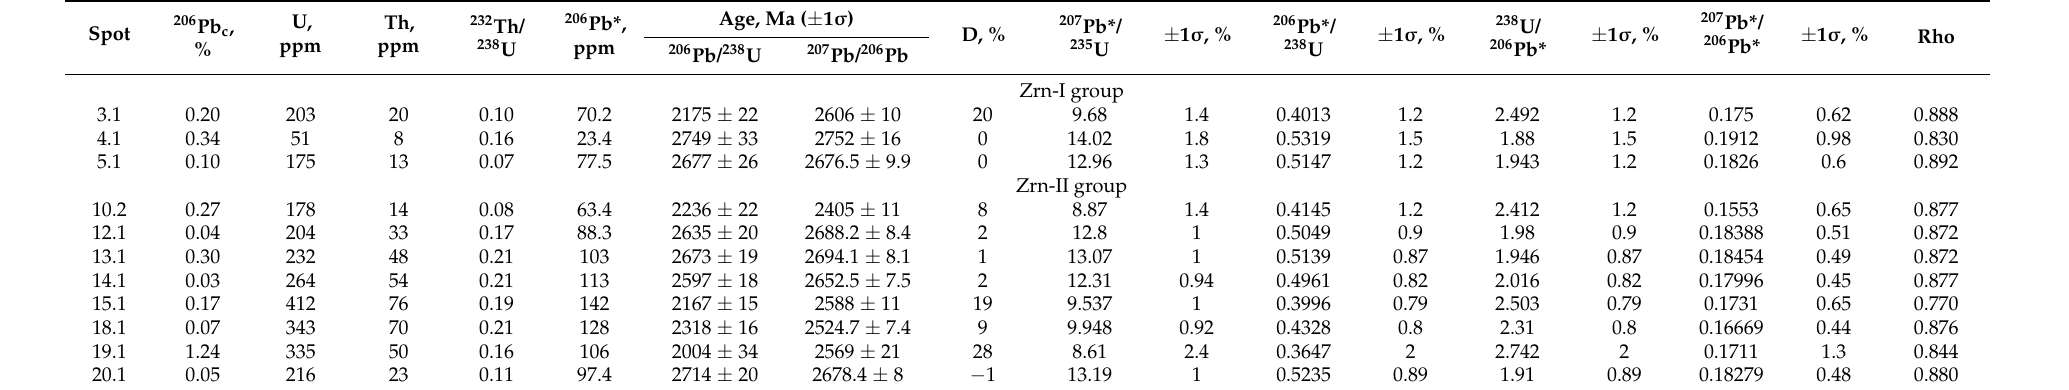
Table 1. U-Th-Pb isotope (SHRIMP-II) data for zircons from massive eclogite